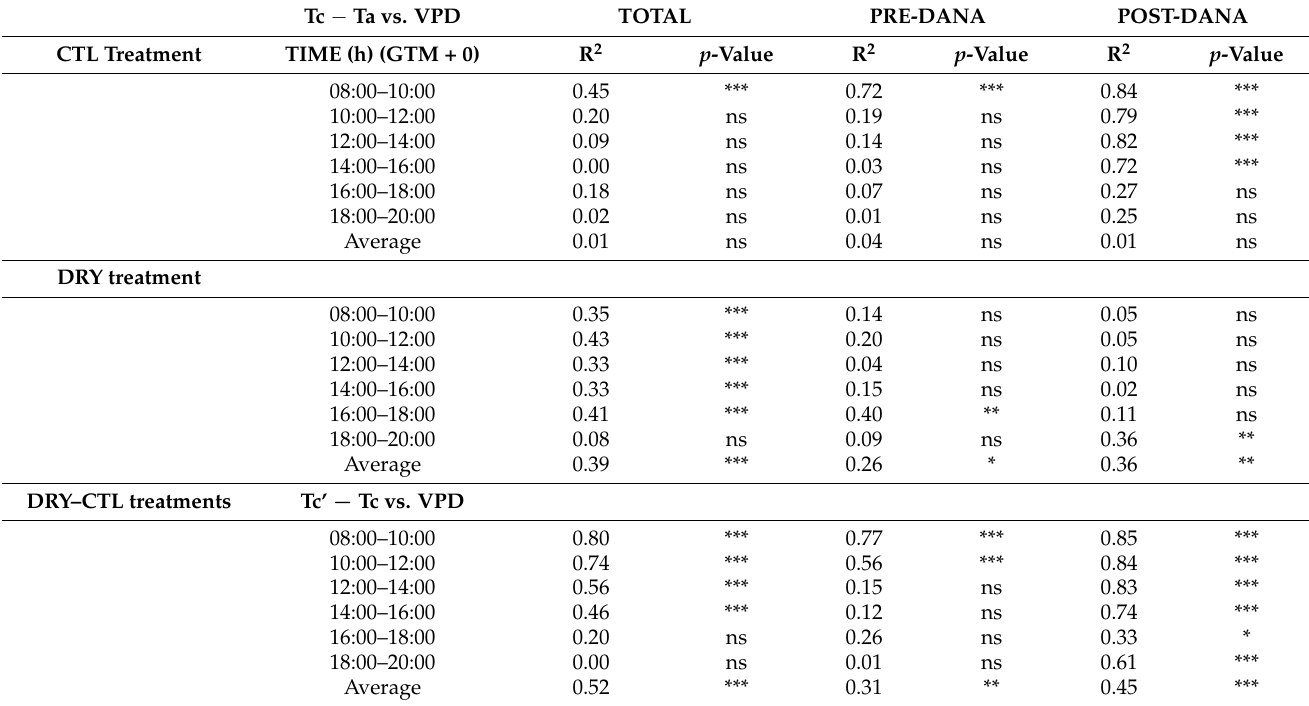
Table 1. Linear relationships between canopy-to-air temperature difference (Tc − Ta), and the canopy temperature difference between DRY (Tc’) to CTL (Tc) treatments (Tc’ − Tc), vs. the measured VPD at different times of the day before the DANA (PRE-DANA), after the DANA occurred (POST- DANA) and during the whole postharvest experiment (TOTAL) for CTL (full-irrigated) and DRY (non-irrigated) treatments. Tc − Ta vs.